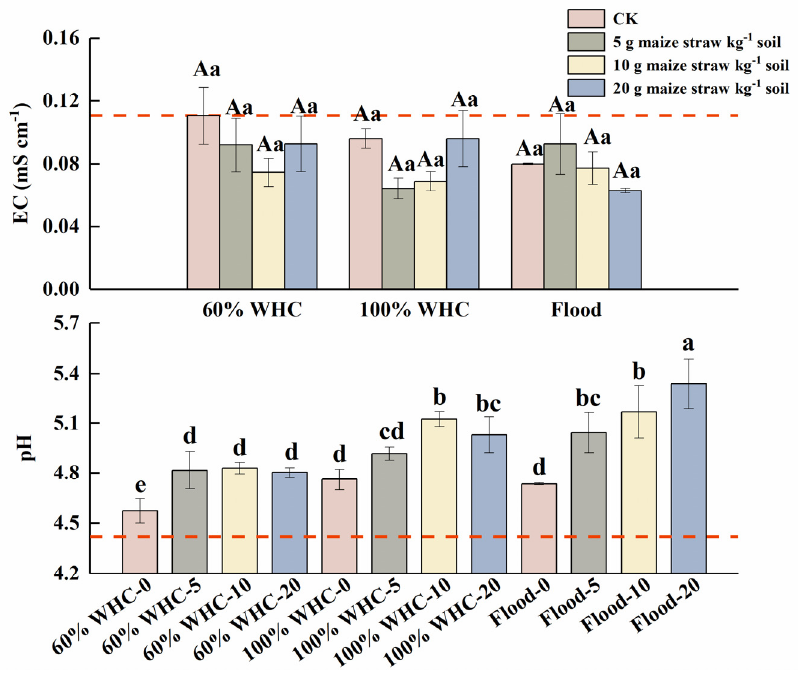
Table 3. ANOVA analyses of the RSD effects of maize application rates and soil water contents on soil properties and populations of soil-borne pathogens.